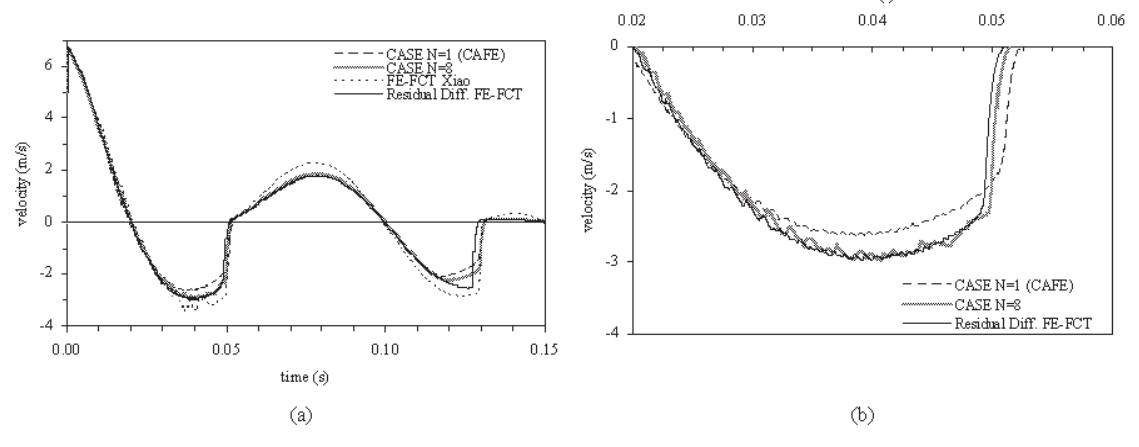
Fig. 5. Results for the velocity of m 1 on two time scales using 81 fluid DOF.